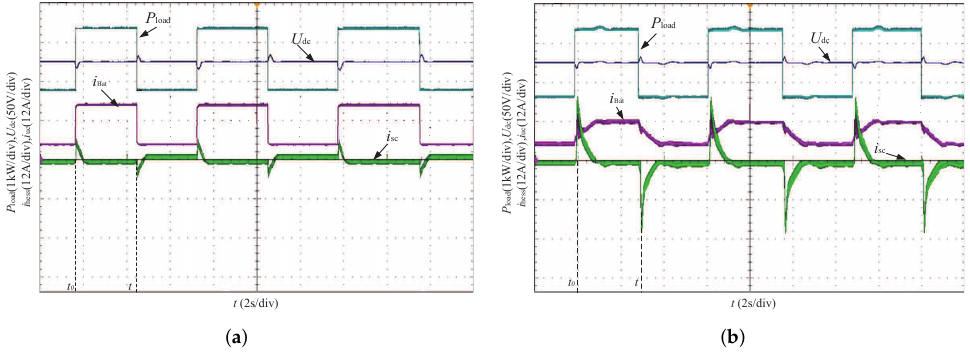
Figure 8. Experimental comparison of HESS with pulsating load: ( a ) without adaptive energy optimization (AEO); ( b ) with adaptive energy optimization